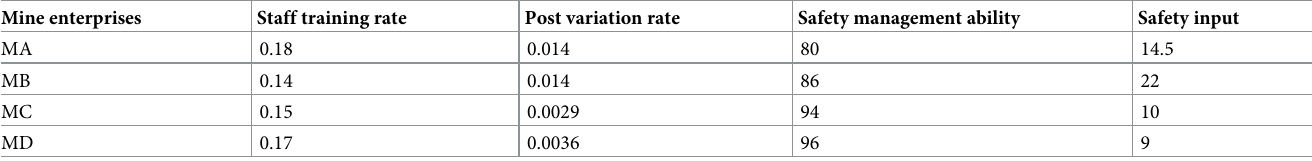
Table 1. Basic information of mine